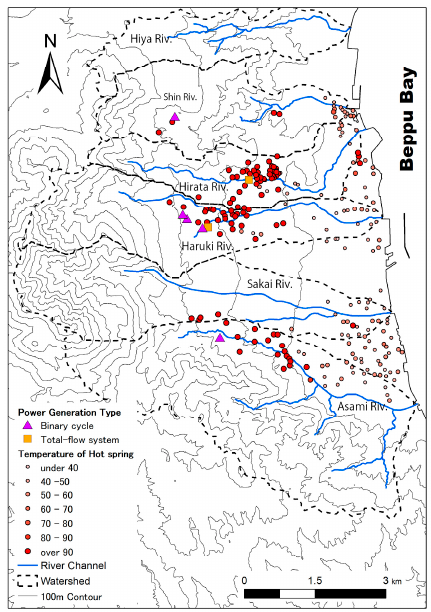
Figure 1. Distribution of hot springs and hot spring power plants with temperatures in six river basins of the Beppu area. Source: Yamada, M., based on the literature [19,20].